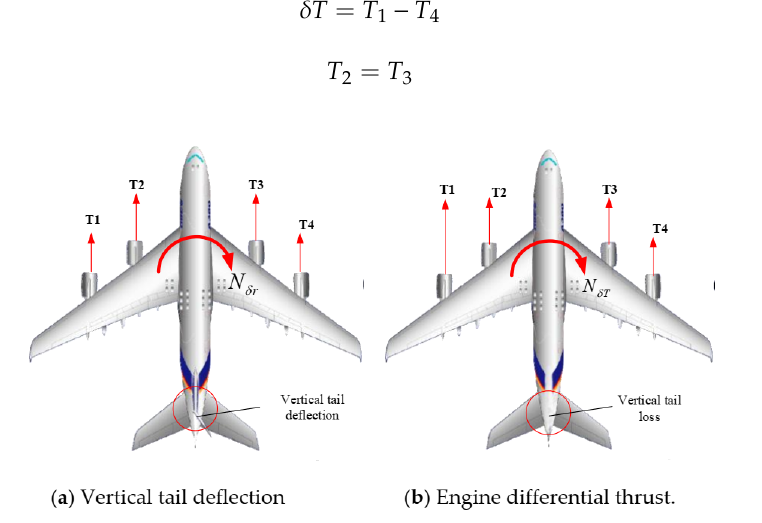
Figure 1. Diagram of vertical tail deflection and engine di ff erential